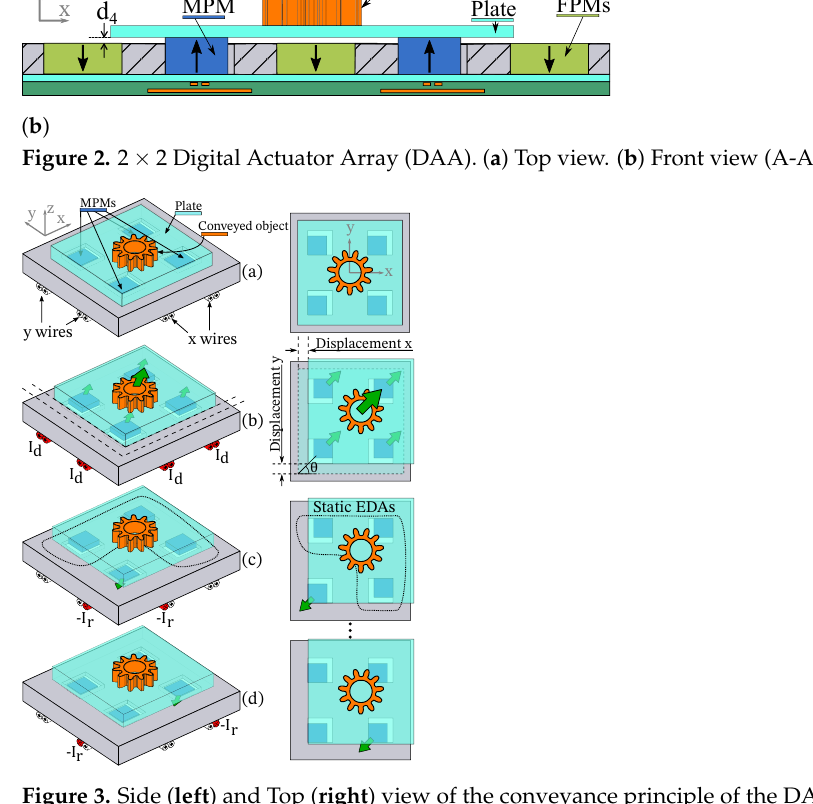
Figure 3. Side ( left ) and Top ( right ) view of the conveyance principle of the DAA. A collaborative effort of the MPMs and individual return of each one (one displacement step